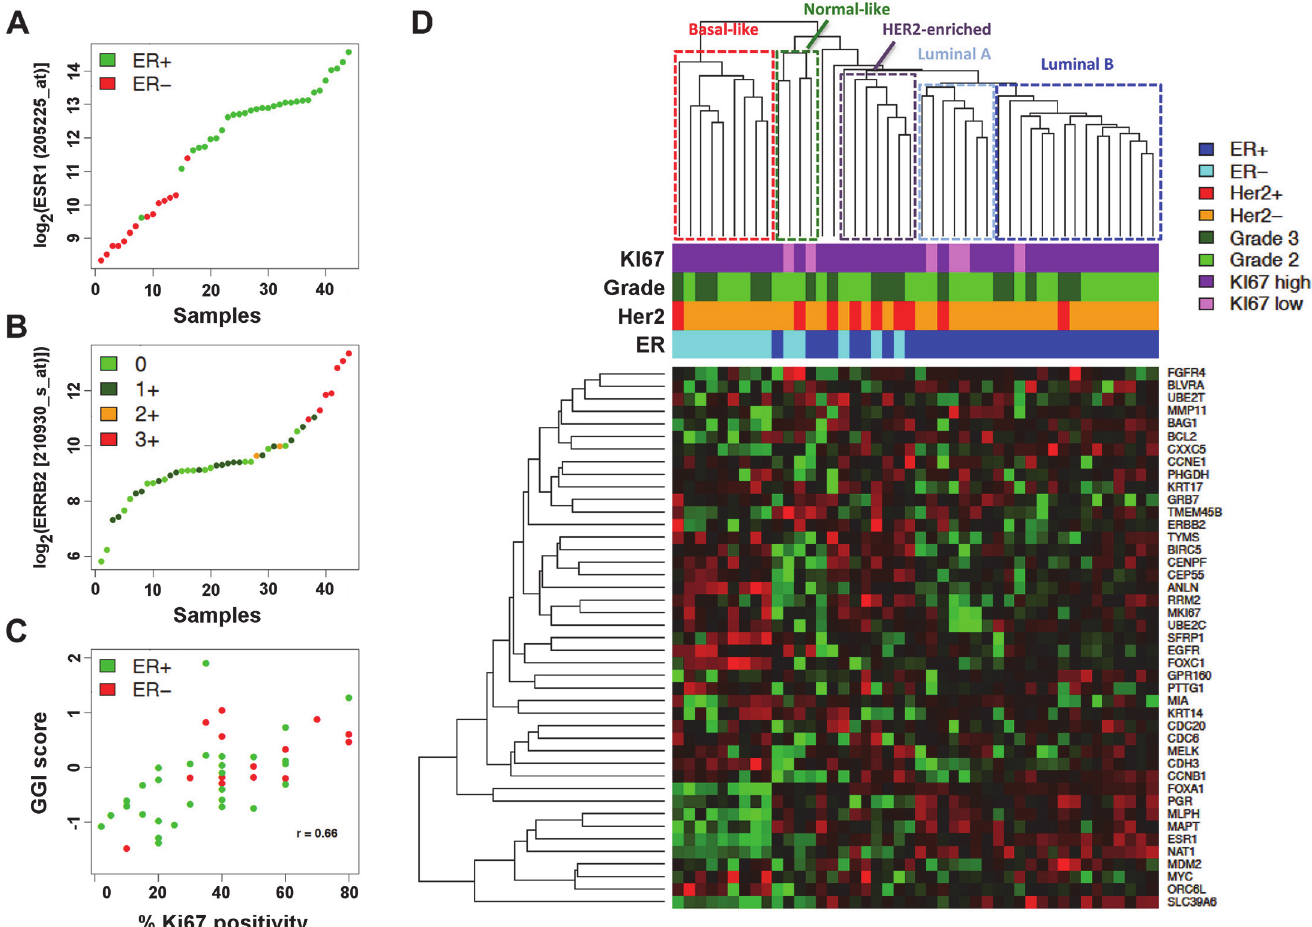
Fig 5. Biological reliability of Affmetrix FFPE data. A. Agreement between ESR1 gene expression and IHC-derived ER status in the cohort of 44 good quality FFPE samples. B. Agreement between ERBB2 gene expression and IHC-derived Her2 positivity in the same cohort. C. Comparison between the Genomic Grade Index and IHC-derived Ki67 positivity as independent estimators of tumor proliferation rate in the same cohort. D. Hierarchical clustering using the PAM50 gene signature. Samples belonging to the 5 molecular subtypes are indicated by dashed rectangles. Pathological definition of ER, Her2, Ki67 and grade are shown according to the color code on the